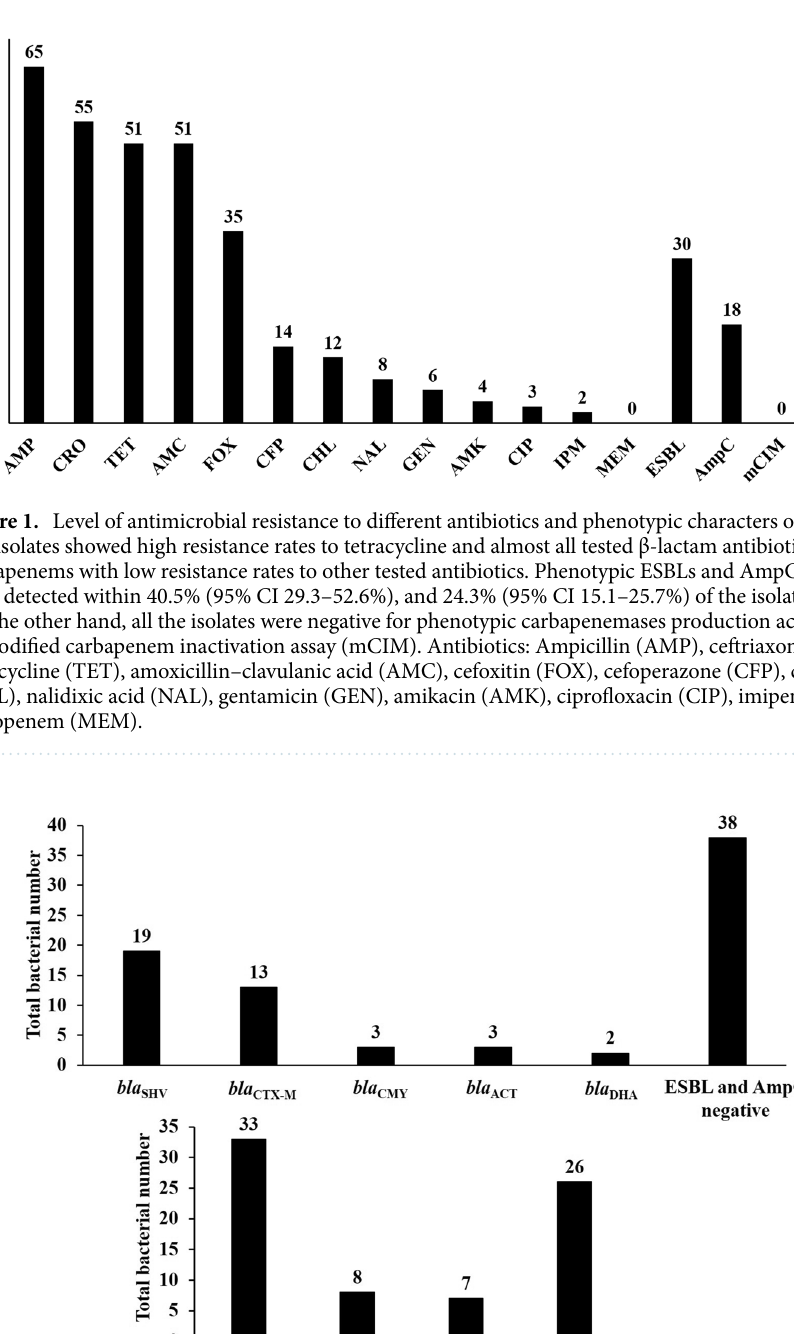
37.2%) of the isolates; 18 isolates contained bla SHV-12; a single isolate possessed bla SHV-11 . The second most preva-